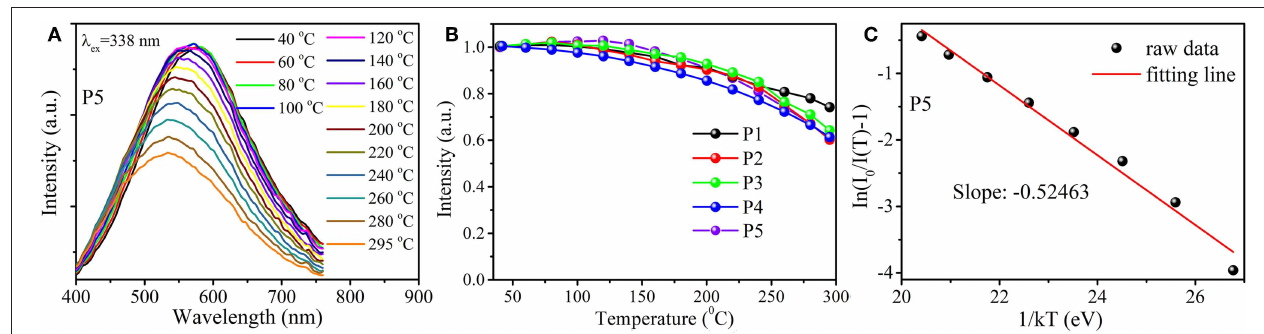
FIGURE 4 | (A) Emission spectra of sample P5 at temperature from 40 to 295 ◦ C under irradiation at 338nm; (B) Integrated emission intensities of samples P1–P5 with various temperatures; (C) Relationship of In[I 0 /I(T)-1] with respect to 1/ k T for sample P5.